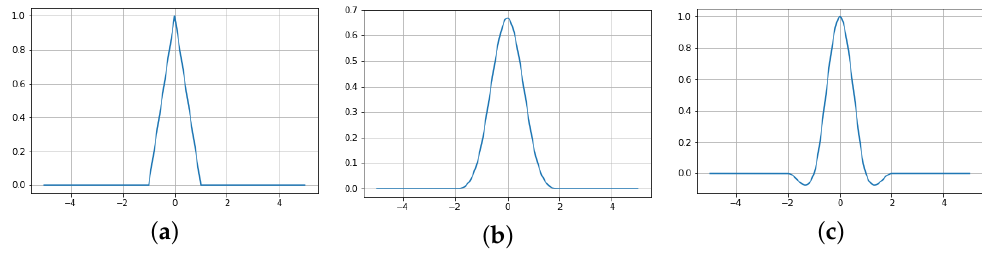
Figure 7. Reconstruction functions: ( a ) bilinear, ( b ) B-spline, and ( c )